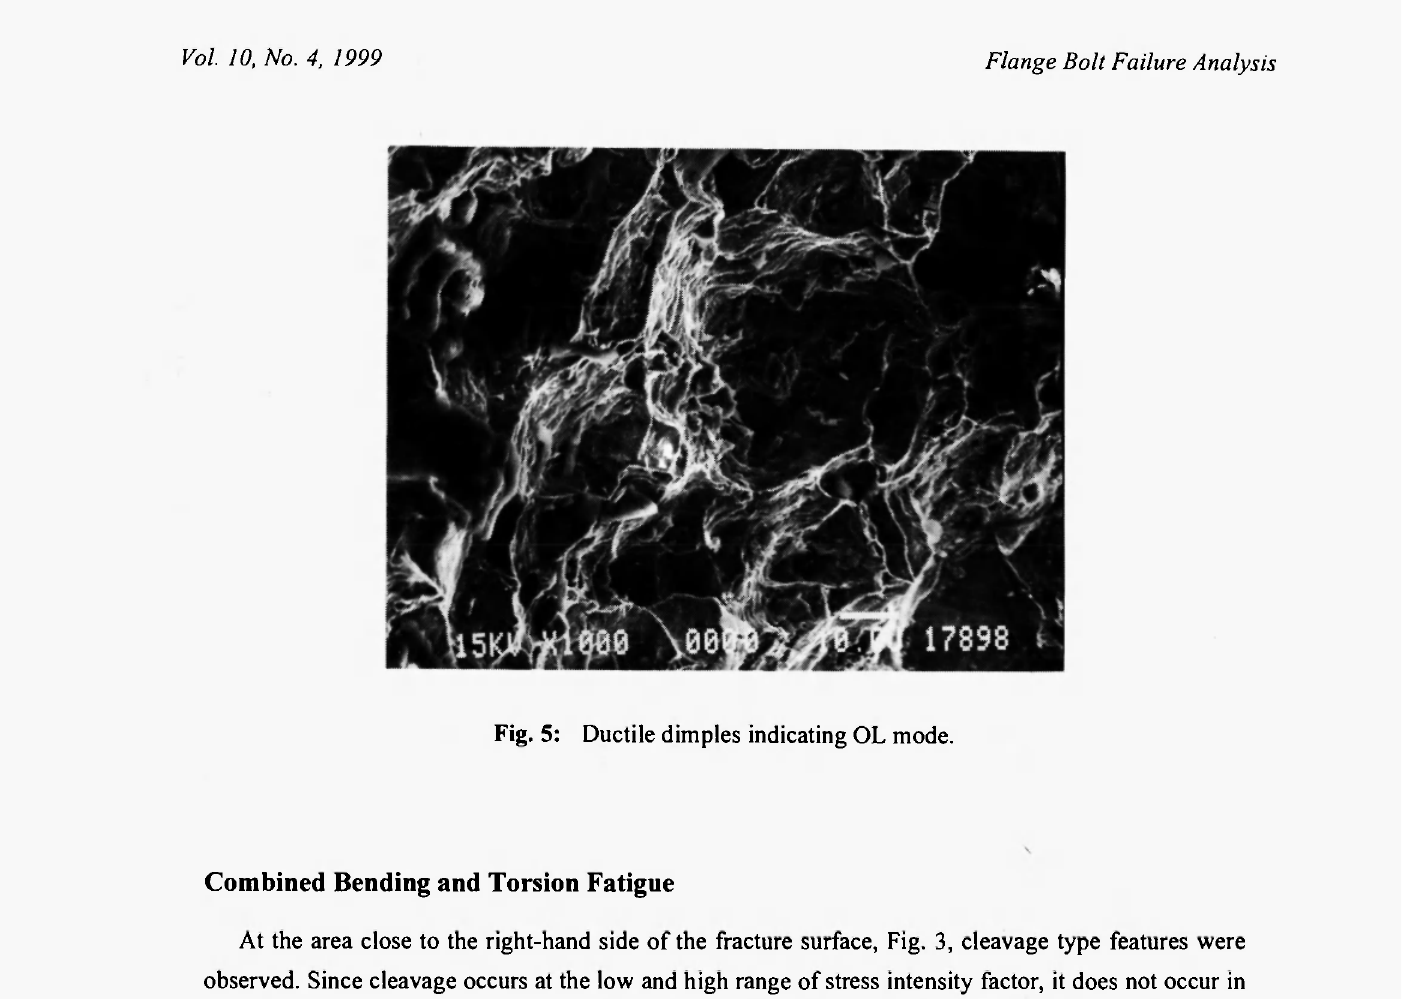
Fig. 5: Ductile dimples indicating OL